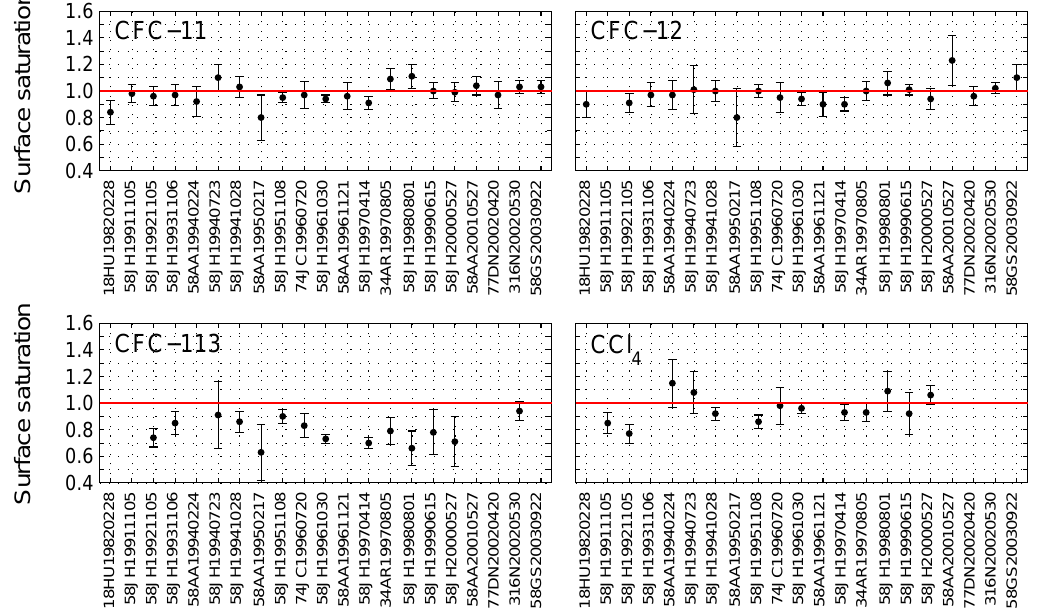
Figure 9. Surface saturations (upper 20dbars) of the CFCs in the Nordic Seas cruises of CARINA. The error bars show the standard deviations. The cruises are sorted chronologically in order to see any trends in the data.